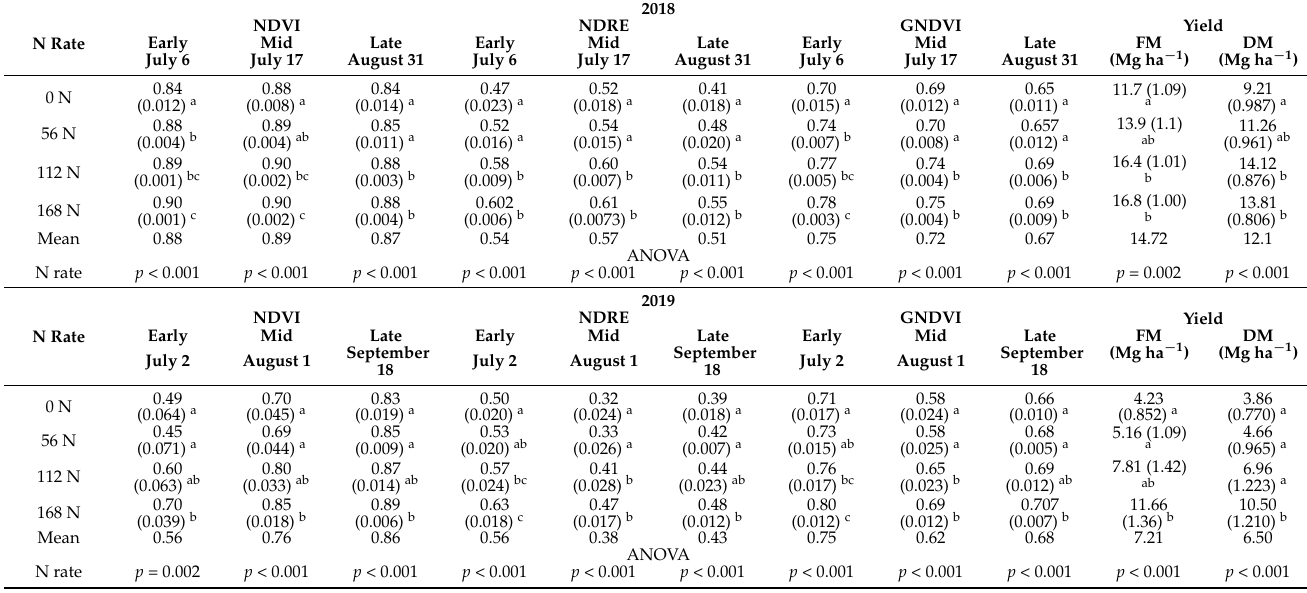
Table 5. Average NDVI, NDRE, GNDVI, and dry matter (DM) yield, and fresh matter (FM) yield (Mg ha − 1 ) in response to nitrogen in 2018 and 2019 obtained from two 3 m x 23 m machine harvest areas in Urbana, IL, USA. Numbers in parenthesis indicate standard error of the differences in means when analyzed by date. Different letters indicate statistical differences in means due to N at p <